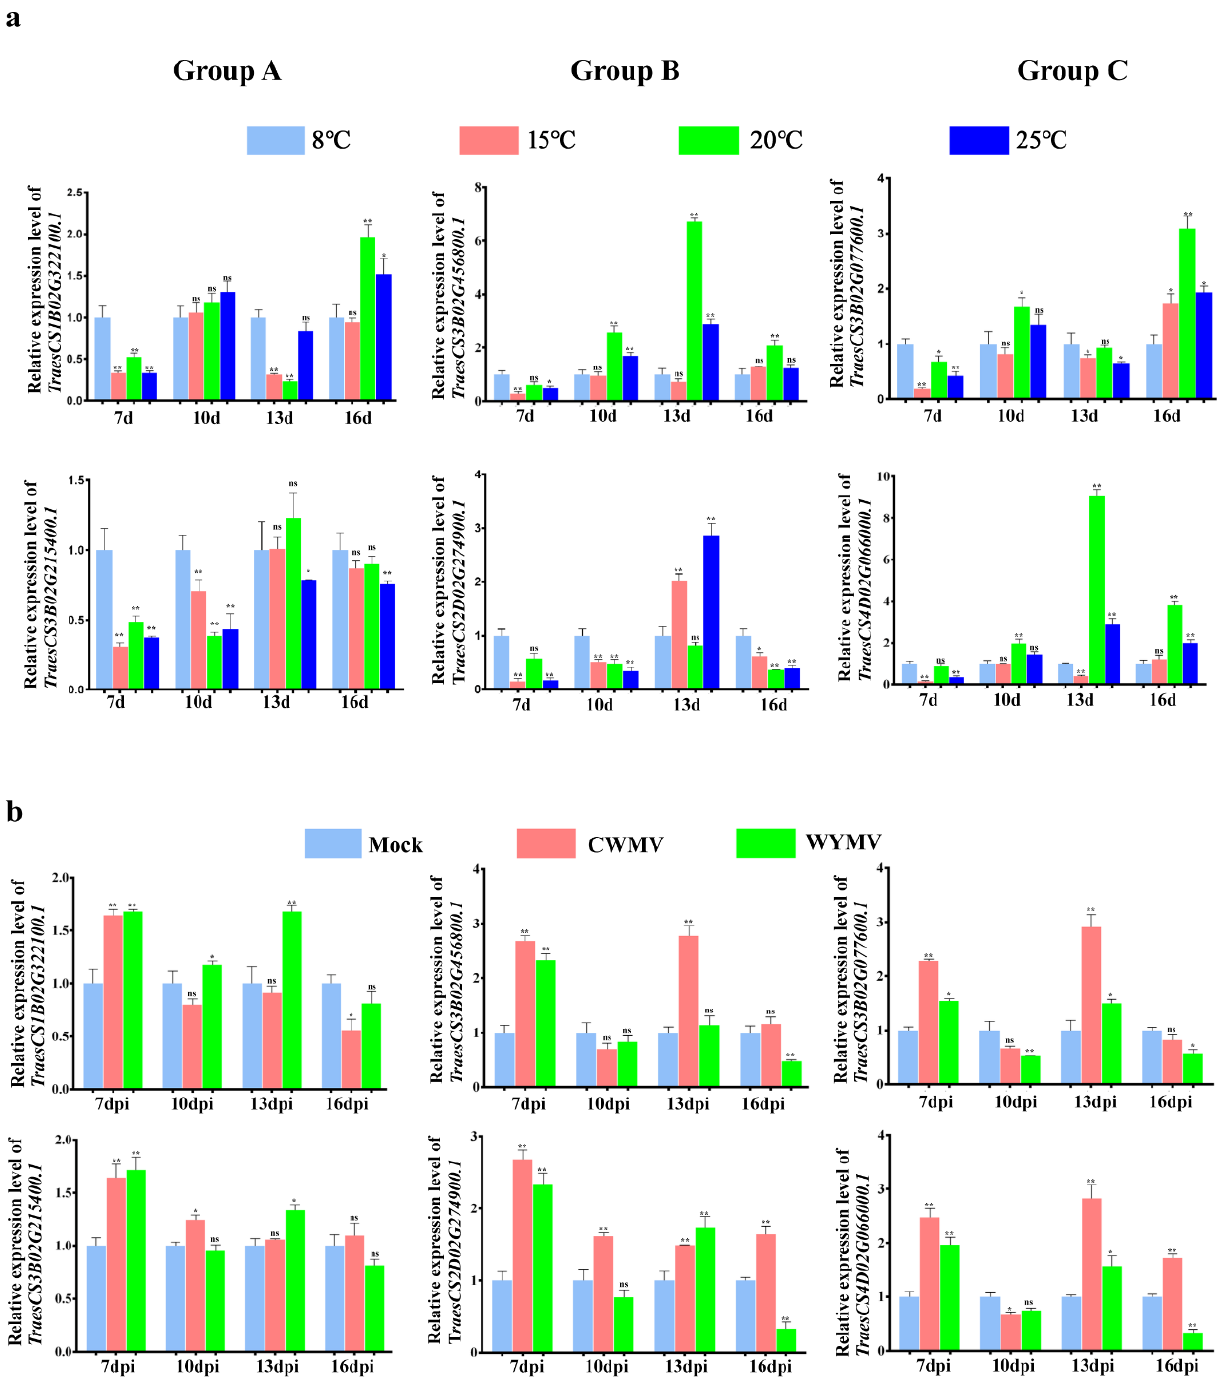
Figure 10. Expression analysis of selected TaCystatins genes under biotic or abiotic stress. ( a ) Expression profiles of selected TaCystatins genes under different temperatures calculated by RT-qPCR. Means ± standard deviations (SE) were deciphered from three biological replicates and each biological replicate had three technical replicates. Note: ns, not significant; **, p < 0.01; and *, p < 0.05 (Student’s t -test). ( b ) Expression profiles of selected TaCystatin genes under viral infection analyzed by RT-qPCR. Means ± standard deviations (SE) were deciphered from three biological replicates and each biological replicate had three technical replicates. Note: ns, not significant; ** p < 0.01; and * p < 0.05 (Student’s t -test).